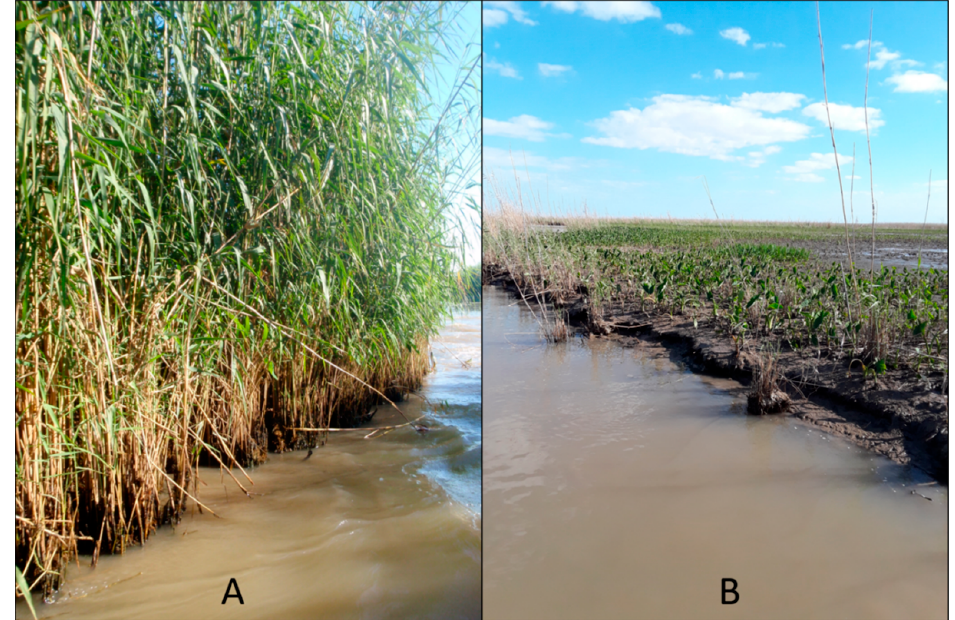
Figure 2. Some channel banks in the Bird’s Foot Delta of the Mississippi River before and after Phragmites dieback. ( A ) Photo taken in 2010 several years before Phragmites dieback began. Then, the roots and stems appeared dense and strong. ( B ) Photo made in 2021 after several years of Phragmites dieback. After dieback, in addition to the loss of height, the roots and stems appear less dense and less resistant to erosion and lateral flow. Both photos are from the Pass A Loutre Wildlife Management Area.